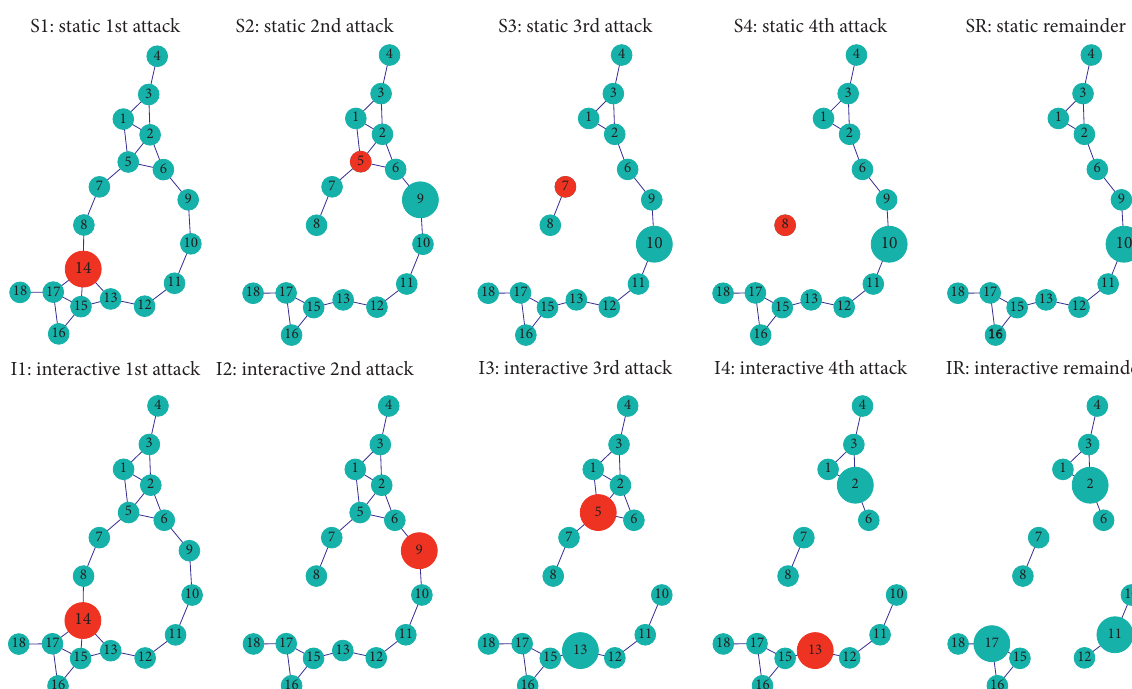
Figure 1: Static betweenness attack and interactive betweenness attack on an example network. The node with the highest betweenness is highlighted with larger node size. The red node represents the attacked node in each